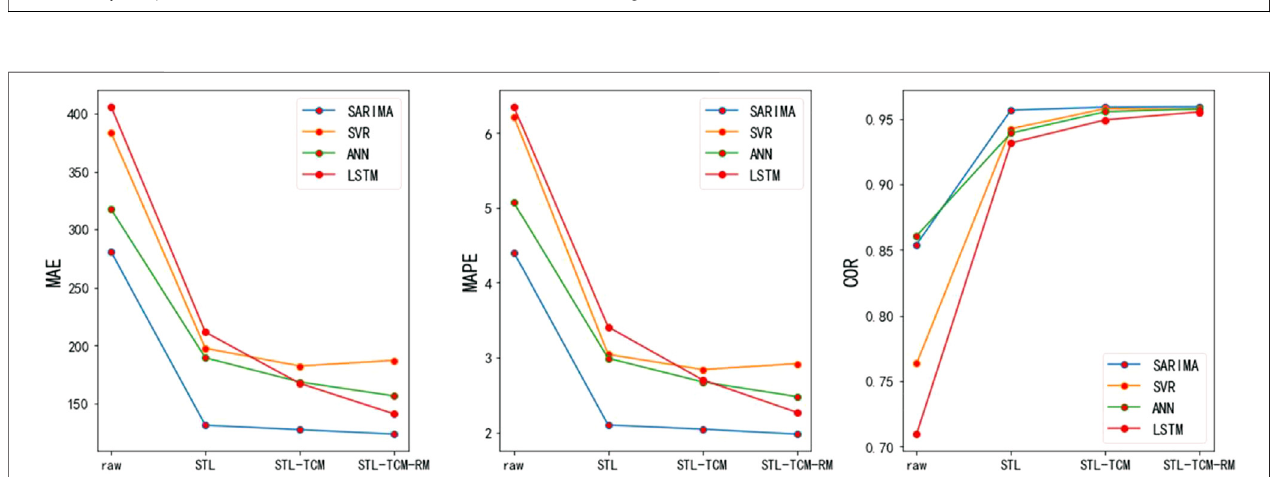
FIGURE 7 | Comparison between different models for 2-month ahead forecasting.